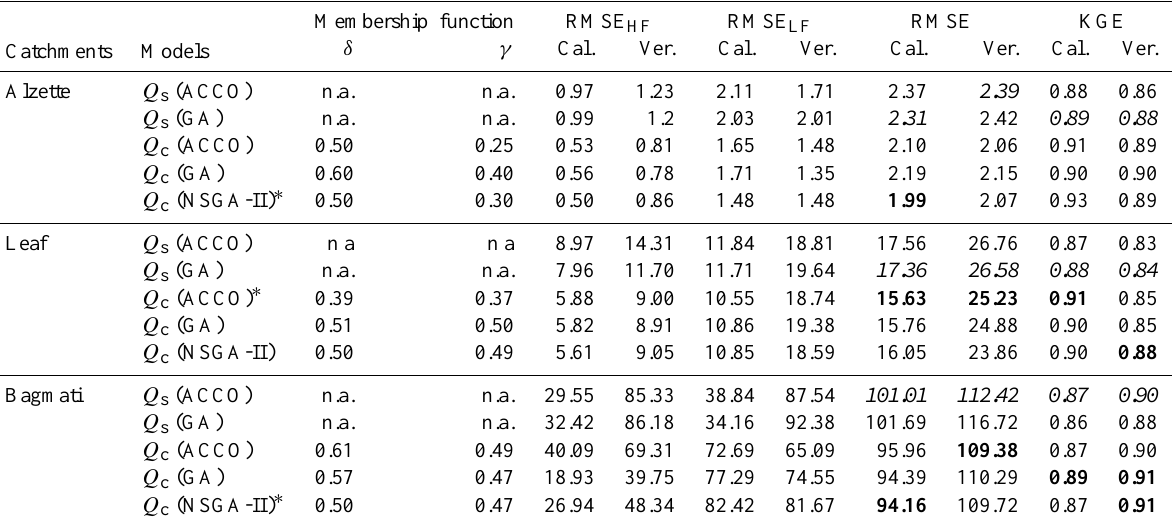
Table 4. The performances of single optimal models (optimized based on classical RMSE) and committee models of various catchments. Committee models are assembled by combination of the weighting scheme WStype I and membership function MFtype A.